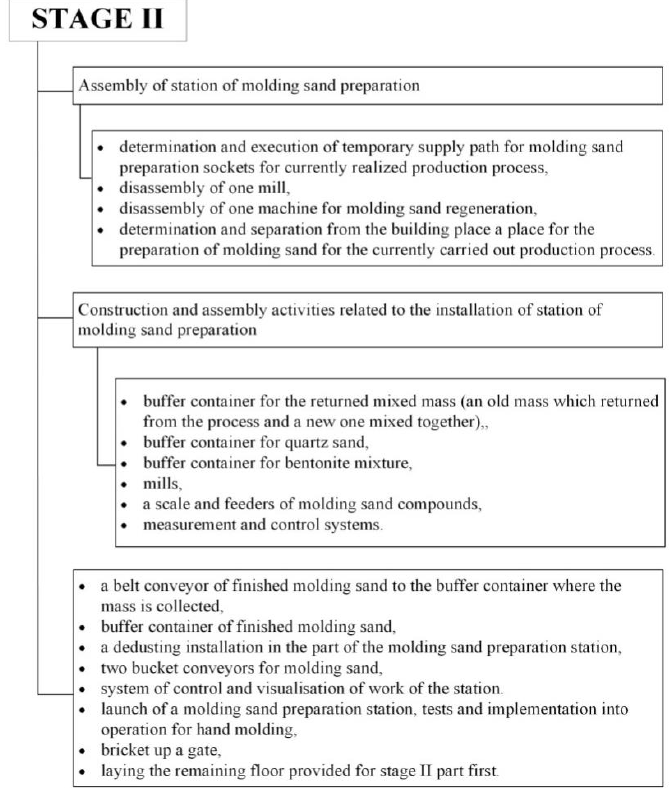
Figure 9. The third stage of modernization of the casting process. The assumed effect of the first stage of modernization was mainly the improvement of the aesthetics of finished products, reduction of the number of flaw products (caused by mechanical